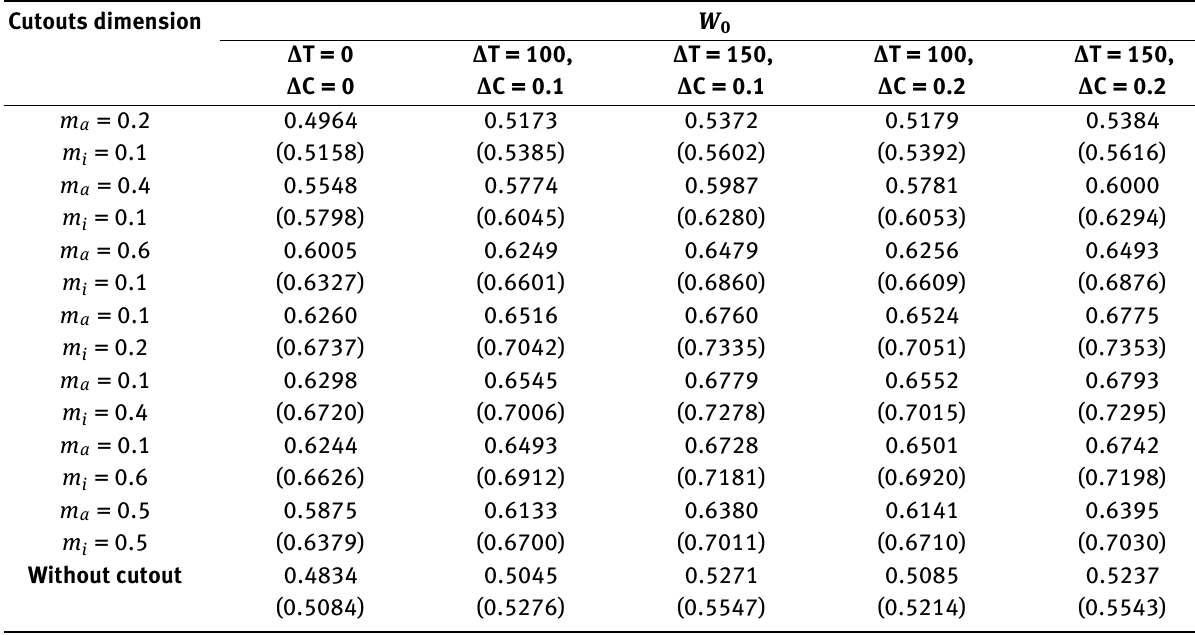
Table 7: Effect cutout dimensions with environmental condition on the central deflection of simply supported (S2) laminated (0/90/C/90/0) sandwich square plate